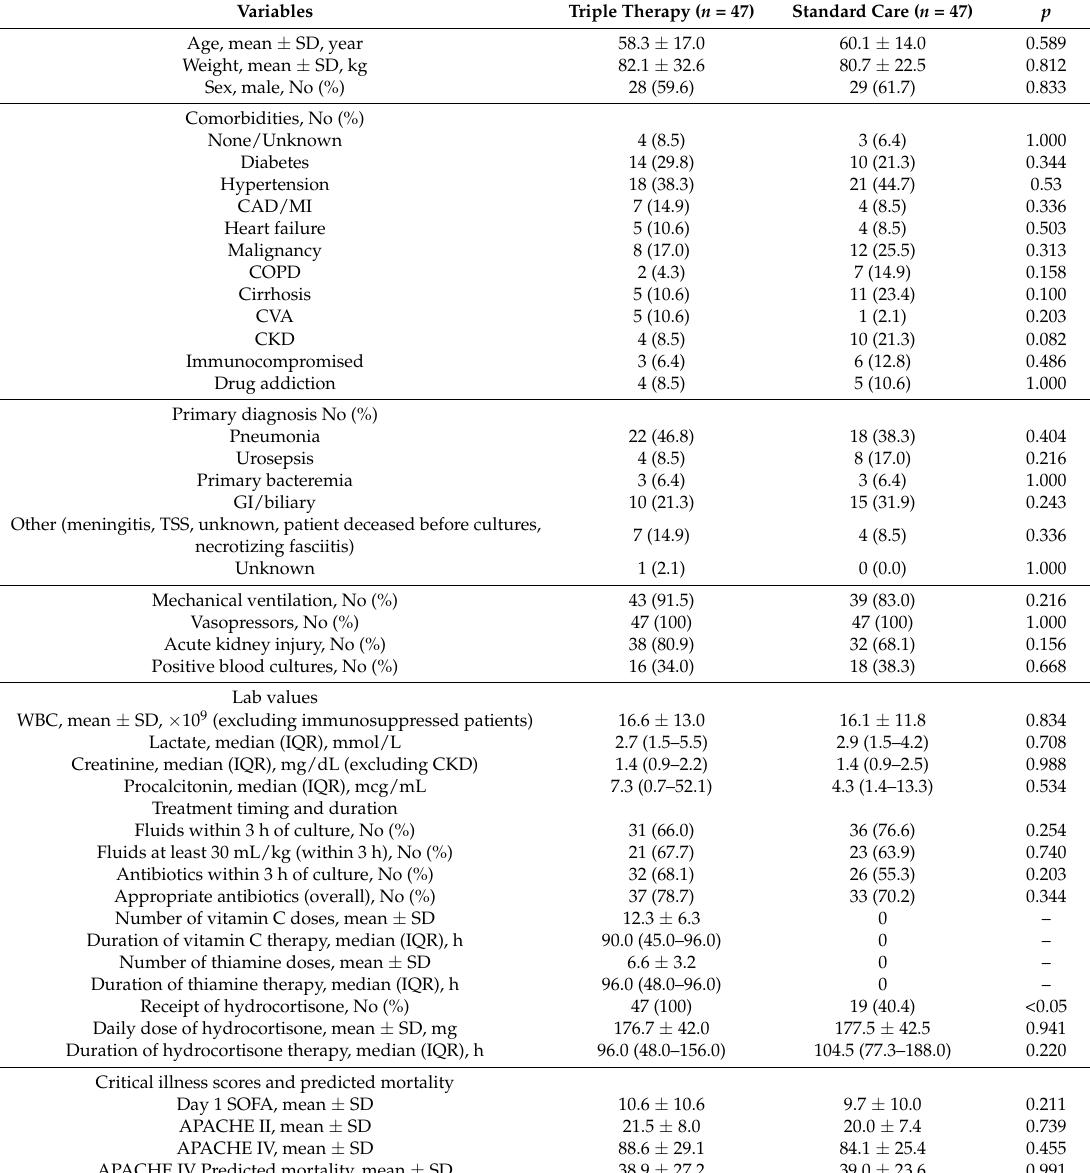
Table 1. Baseline